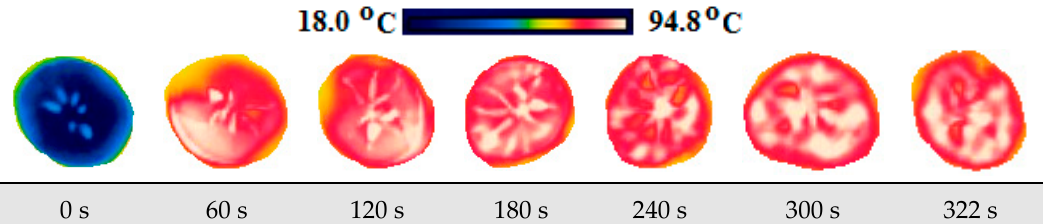
Figure 12. Thermal images of persimmon with 5 mm at 460 W.